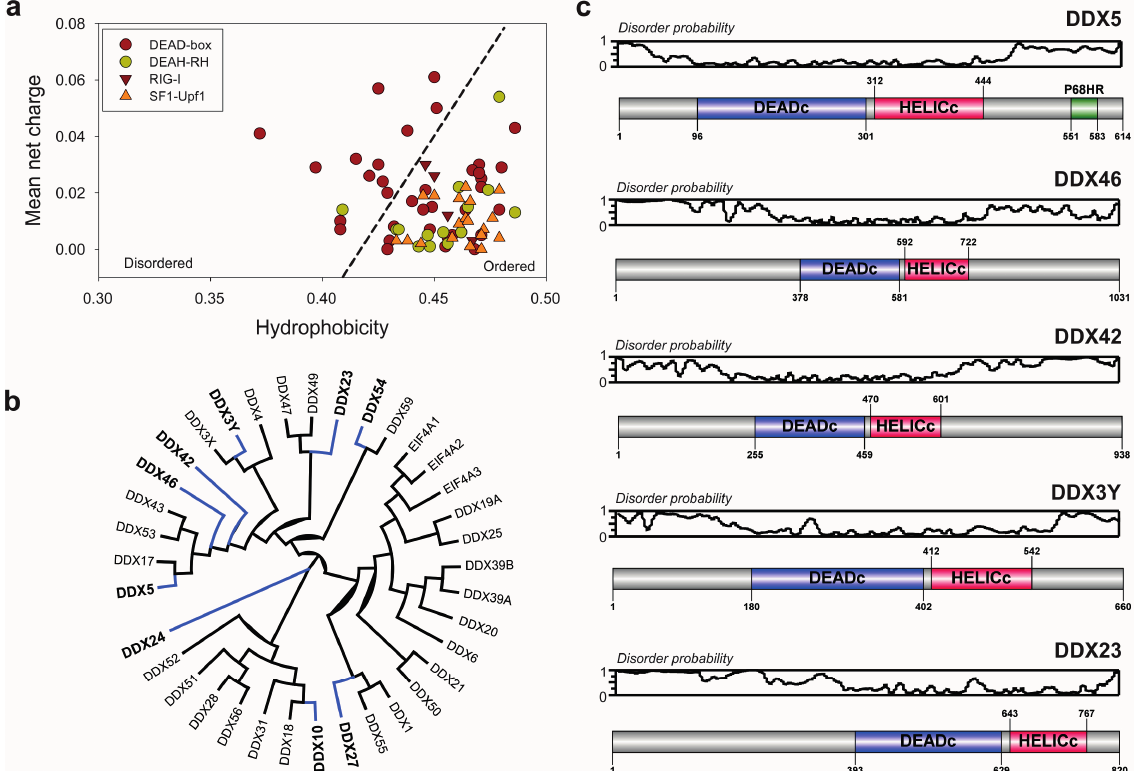
Figure 4. Evidence of the presence of disordered segments in human DEAD-box RNA helicases. ( a ) Uversky plot: hydrophobicity vs. mean net charge plot of human RNA helicases (from [11]). Members of each sub-family of proteins are depicted by a different symbol as indicated in the legend panel. Intrinsically disordered proteins are recognizable by a combination of low hydrophobicity and higher mean net charge. The order-disorder boundary line is defined by the linear function < charge ≥ 2.743 < hydrophobicity > − 1.109 [55]; ( b ) Circular chladogram obtained by multiple sequence alignment of human